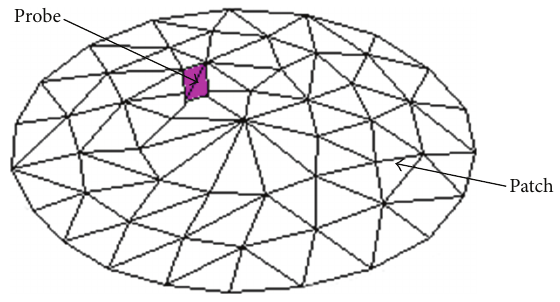
Figure 2: Mesh of triangular patches.